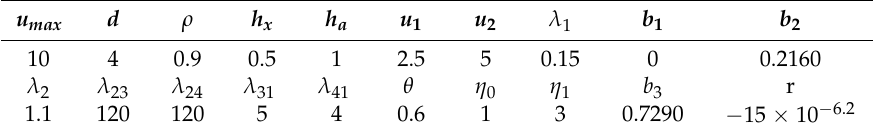
Table 1. Parameters for the numerical example.